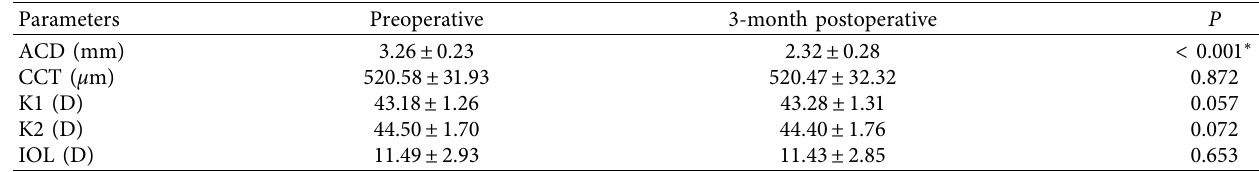
Table 4: Sirius measurements of anterior segment before and after ICL